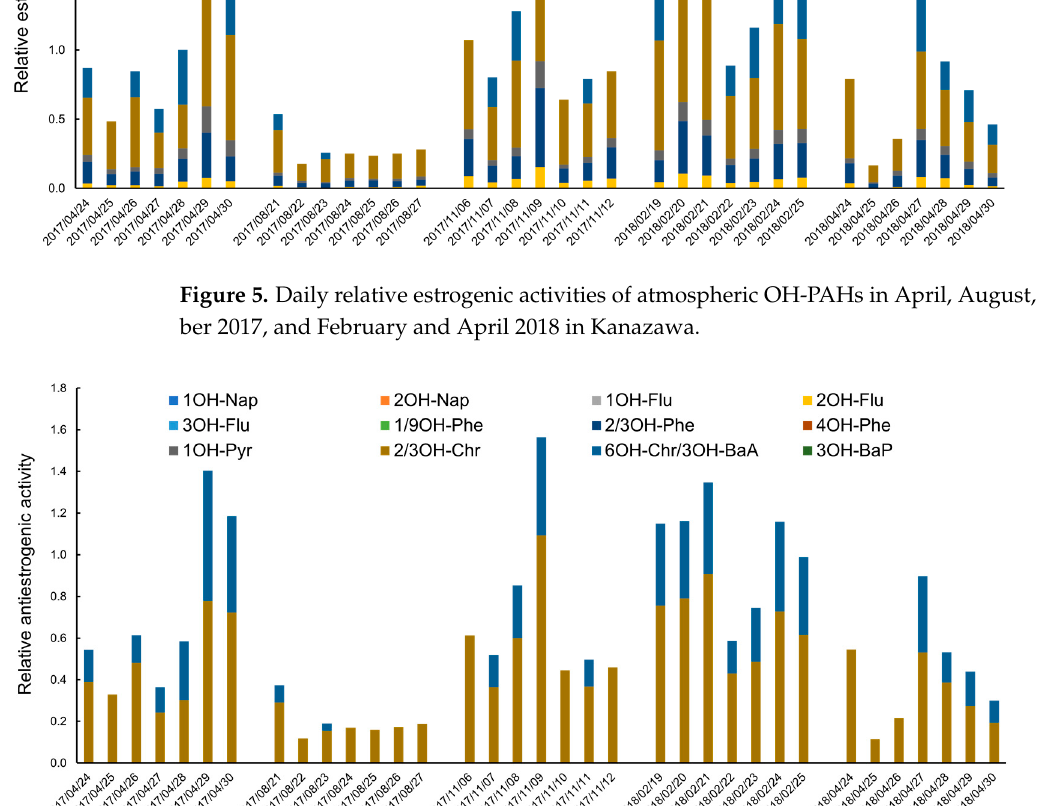
Figure 5. Daily relative estrogenic activities of atmospheric OH-PAHs in April, August, and No- vember 2017, and February and April 2018 in Kanazawa.